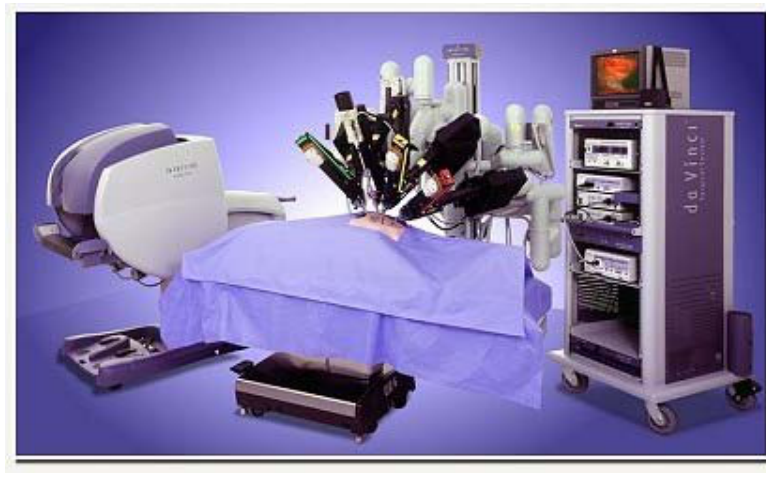
Figure 3. The Da Vinci surgical robot system. Source: www.montefiore.org (/cancer-robotic-prostate-surgery).